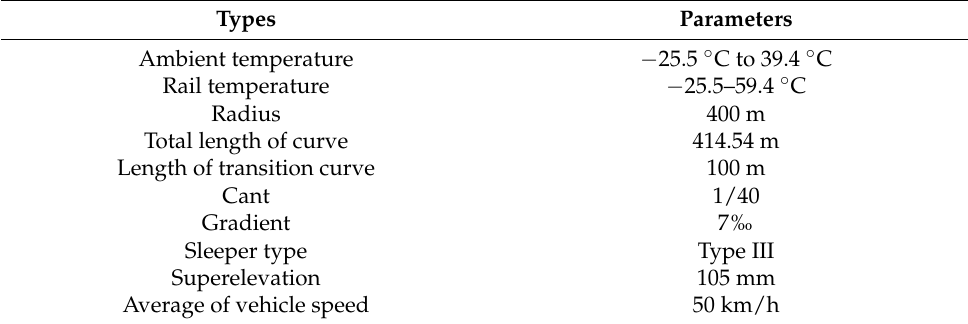
Table 1. Basic parameters of the curve.